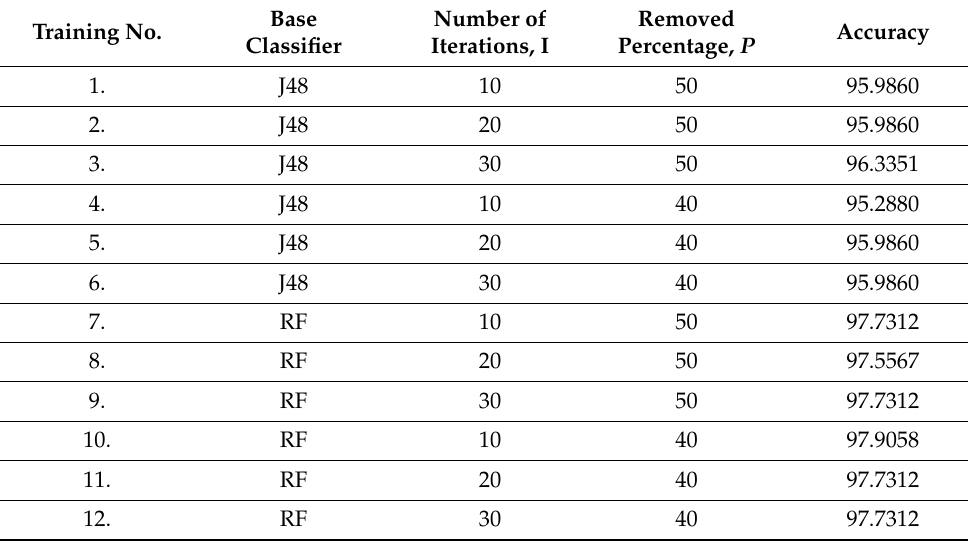
Table 13. Prediction accuracy of rotation forest hyperparameter optimization.